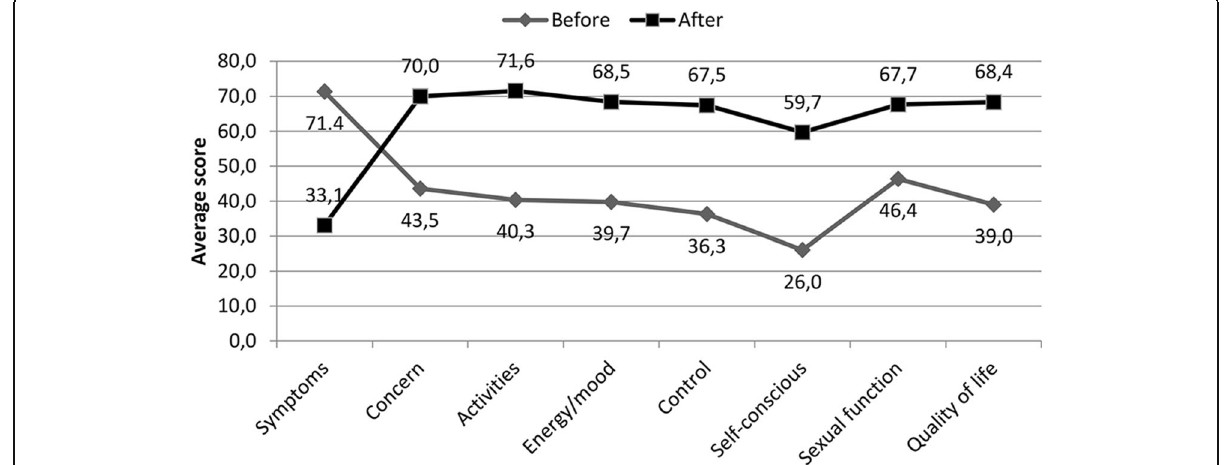
Fig. 2 Average score obtained in the UFS-QOL questionnaire, before and after UFE